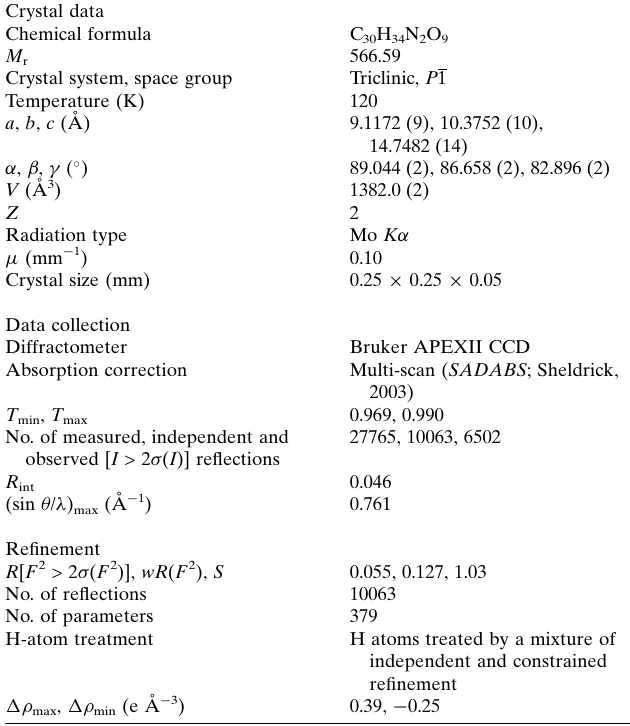
Table 2 Experimental details. Crystal data Chemical